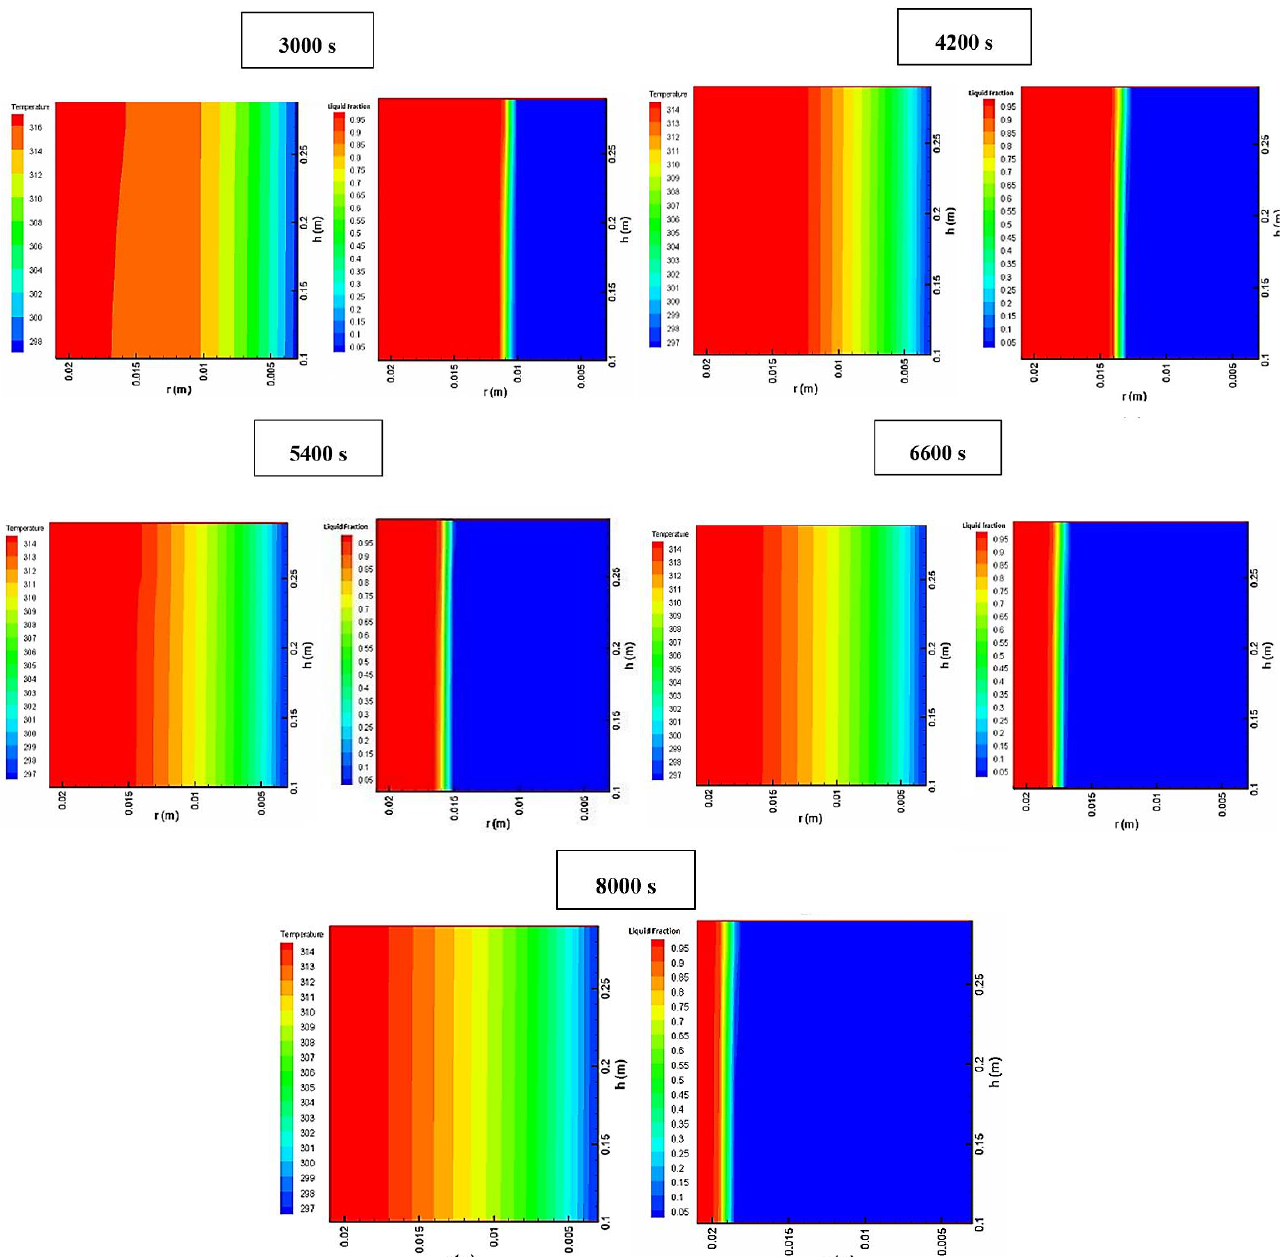
Figure 13. Numerical temperature and liquid fraction contour for discharging process (T = 23 ◦